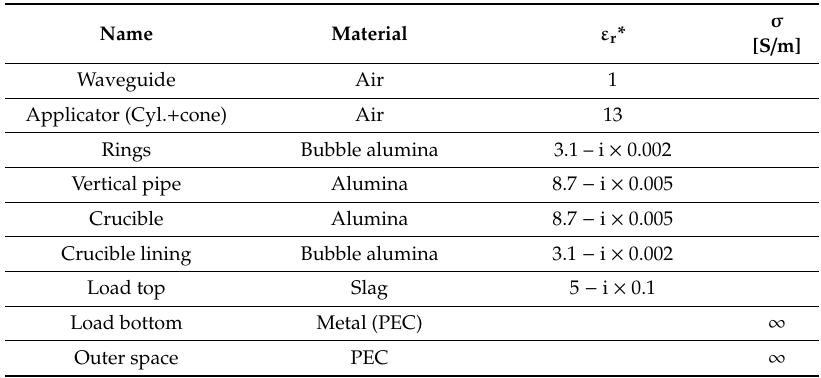
Table 2. Subdomain description referred to Figure 3 and their relative permittivity. The outer space is assumed to be a Perfect Electric Conductor